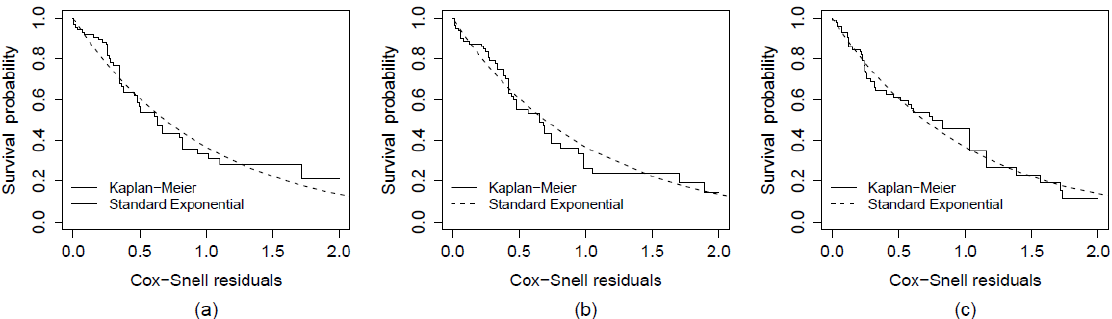
Figure 1. Cox–Snell residuals from the ( a ) Log-logistic model for Azamax ® , ( b ) Weibull model for Organic neem ® , and ( c ) Log-normal model for Natuneem ® . Survival curves estimated by the models — Log-logistic for Azamax ® , Weibull for Or- ganic neem ® , and Log-normal for Natuneem ® — demonstrate an inverse relationship be- tween increasing doses and survival time (Figures 2 – 4). For insects without exposure to